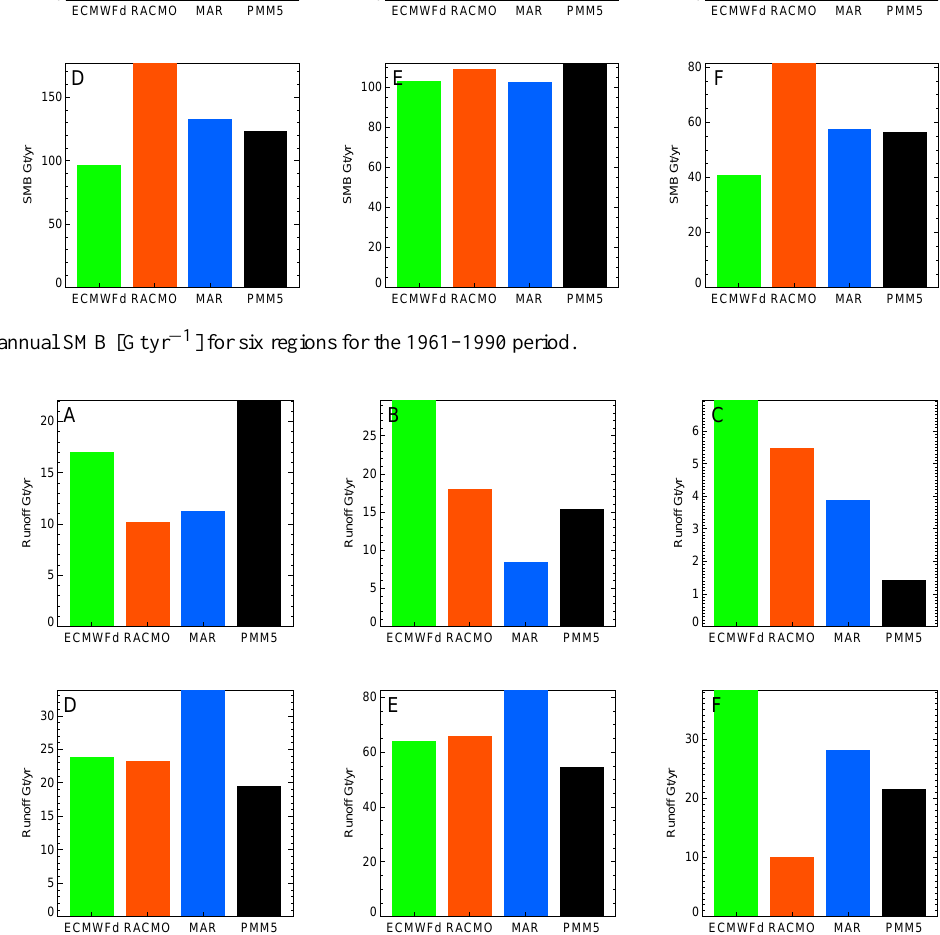
Fig. 8. Average annual runoff [Gtyr − 1 ] for six regions for the 1961–1990 period.